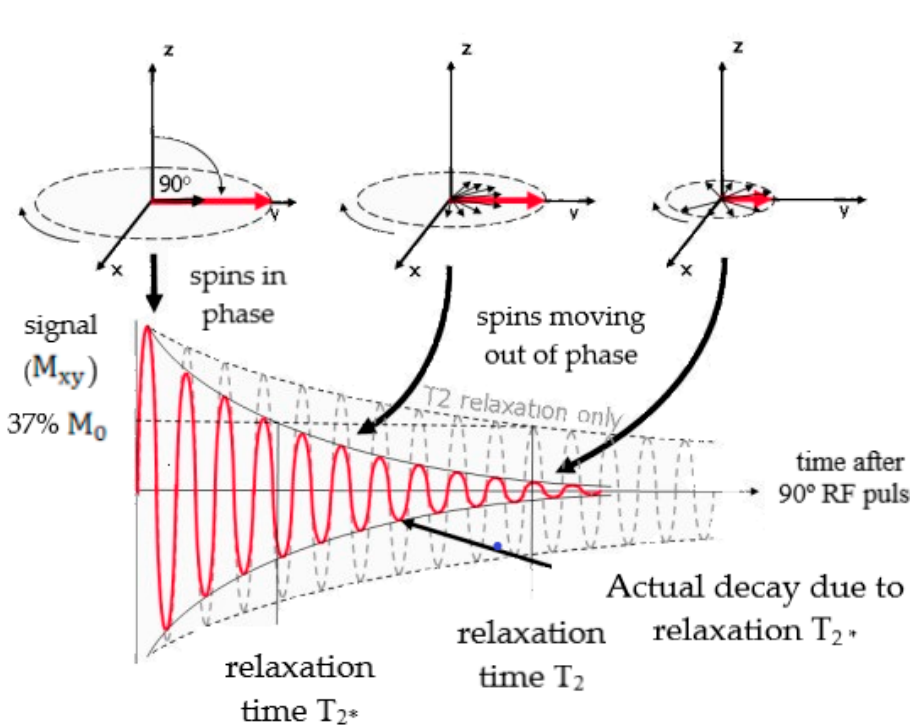
Figure 2. Scheme of T 2 and T 2 * relaxation when a 90 ◦ RF pulse was applied to a system at equilibrium. M xy present a maximum amplitude when the RF pulse is applied, then returns gradually to its equilibrium value. This decaying signal is called Free Induction Decay (FID). Adapted from Ridgway,